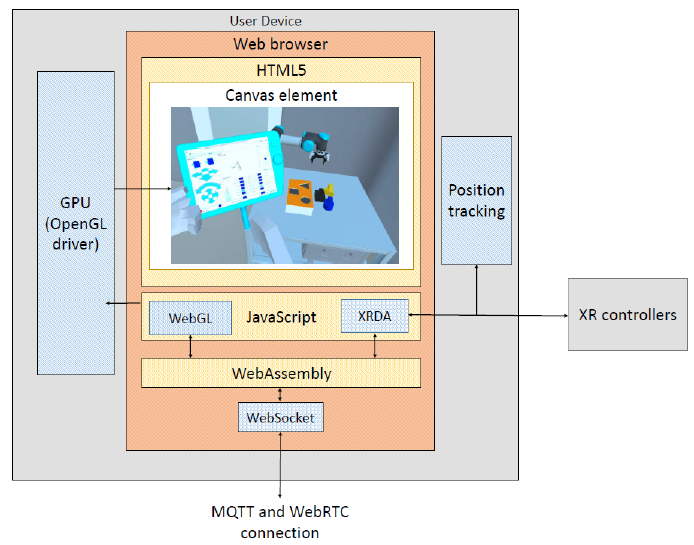
Figure 3. Structure of